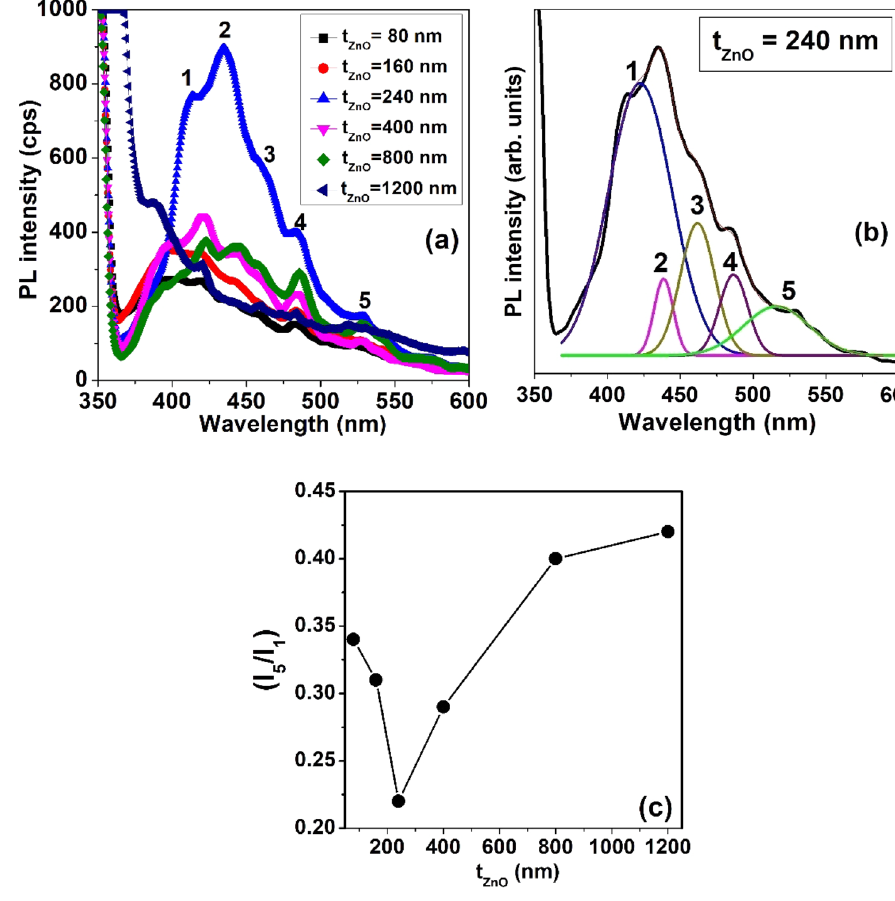
Fig. 4 a Photoluminescence spectra of ZnO thin films deposited at different t , b ZnO Multi-peak Gaussian fitting for the PL spectra of ZnO film with t = 240 nm, and c ZnO Ratio of oxygen vacancies